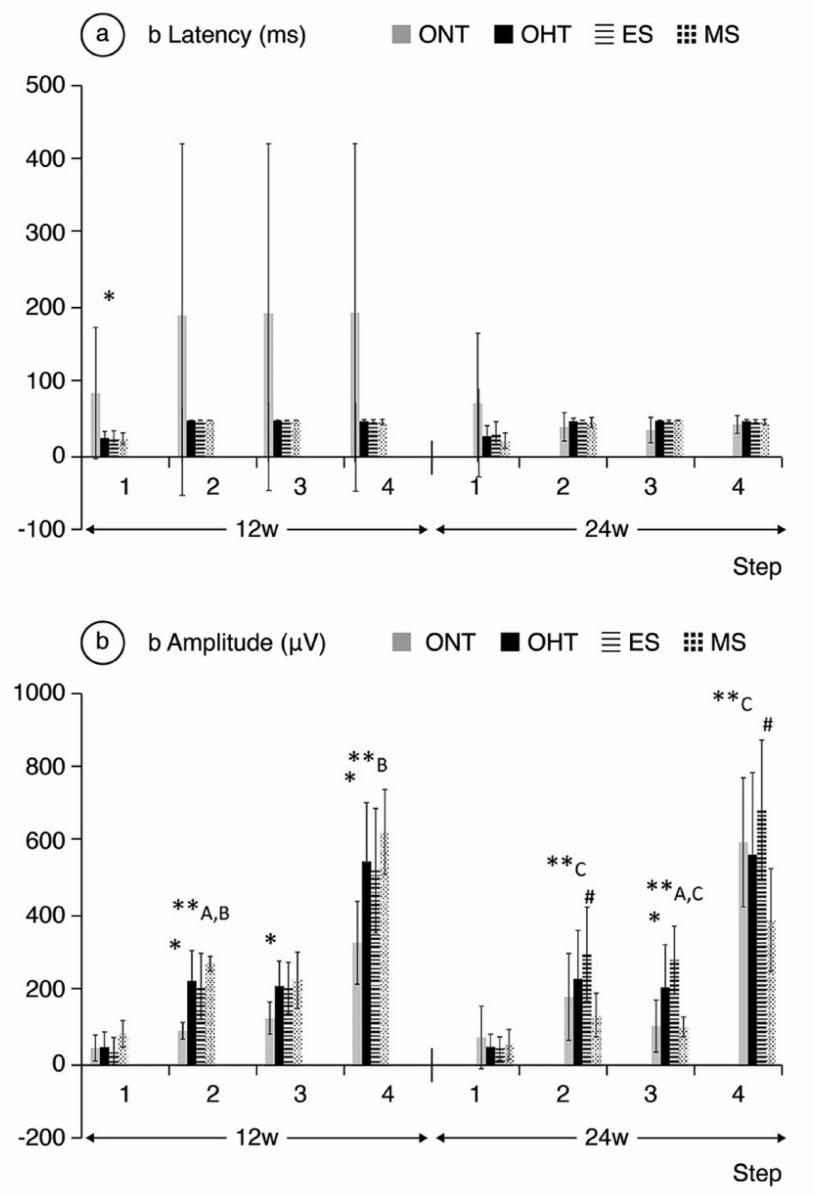
Figure 5. b-wave electroretinographic response in both the ocular normotension and ocular hyperten- sion cohorts and the ocular hypertension sub-groups at weeks 12 and 24. ( a ) b-latency in milliseconds of intermediate cells under scotopic conditions. ( b ) b-amplitude in microvolts of intermediate cells under scotopic conditions. ONT: ocular normotension group; OHT: ocular hypertension group; ES: episcleral sclerosis group; MS: microspheres group; w: week; ms: milliseconds; µ V: microvolts; * statistical differences between the ONT and OHT cohorts. **: statistical differences between groups (ONT vs. ES vs. MS) (Kruskal–Wallis); #: statistical differences between the ES and MS groups; A: statistical differences between ONT and ES; B: statistical differences between ONT and MS; C: statistical differences between ES and MS. Scotopic test (rod response): step 1: − 40 dB, 0.0003 cds/m 2 , 0.2 Hz (20 recordings averaged); step 2: − 30 dB, 0.003 cds/m 2 , 0.125 Hz (18 recordings averaged); step 3: − 20 dB, 0.03 cds/m 2 , 8.929 Hz (14 recordings averaged); step 4: − 20 dB, 0.03 cds/m 2 , 0.111 Hz (15 recordings